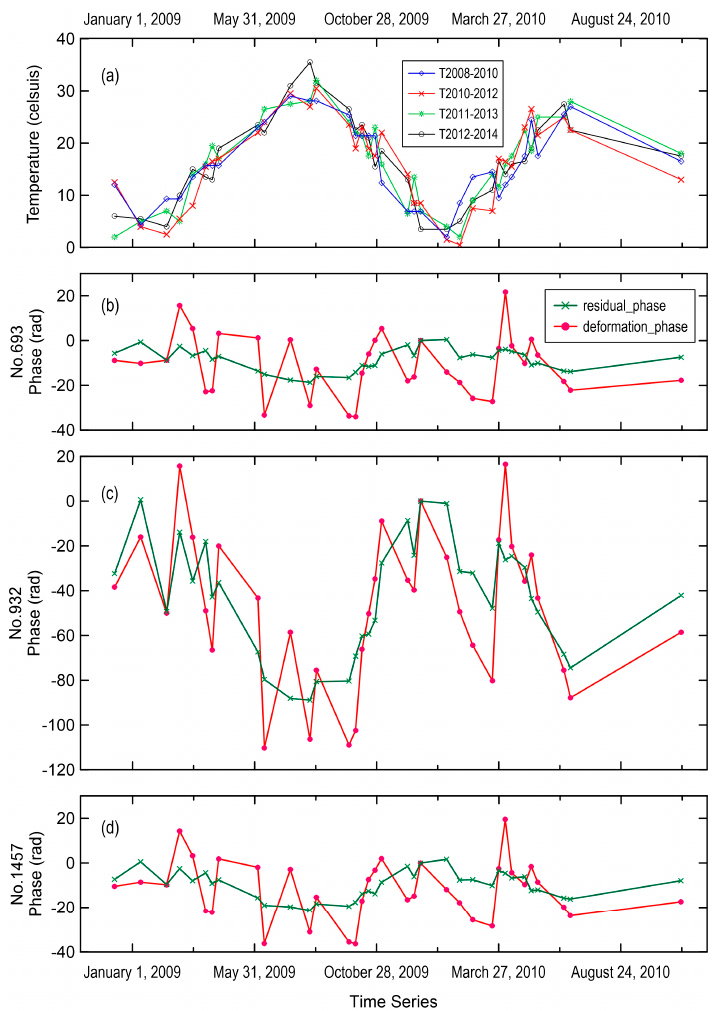
Figure 7. ( a ) Temporal variations of temperature (T2008–2010: interpolated averaged daily temperature records on SAR data acquisition dates. T2010–2012, T2011–2013, T2012–2014: averaged daily temperature records on acquisition dates two, three, and four years later); ( b – d ): Unwrapped deformation phase time series (red dots) and residual time series (green crosses) of PS points 693, 932, and 1457 whose locations are shown in Figure 6.